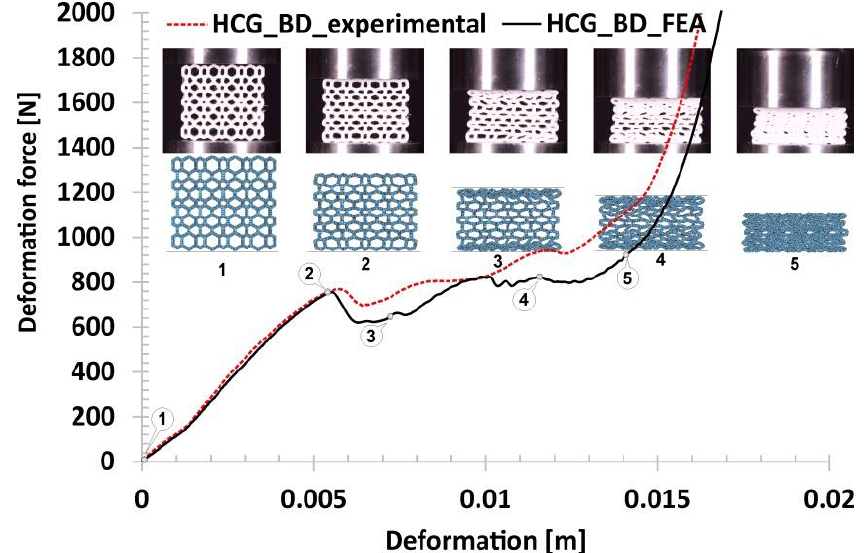
Figure 26. The results of bidirectional gradient honeycomb compression tests obtained based on the FE analysis. Polymers 2020 , 12 , x FOR PEER REVIEW 21 of 24